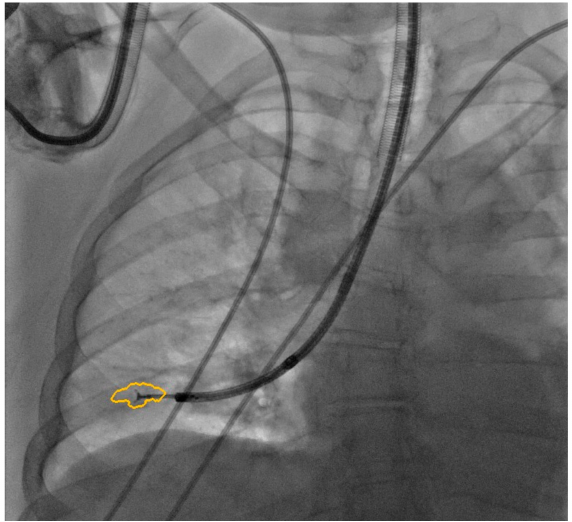
Figure 2. Augmented